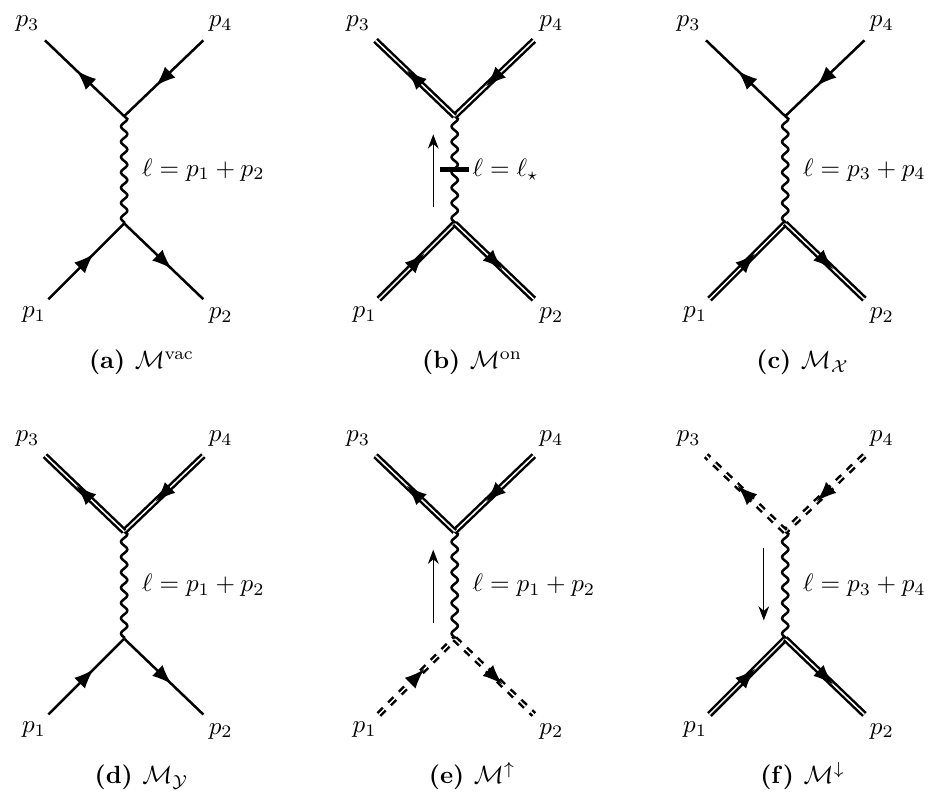
Figure 4. The decomposition (2.23) of the scattering amplitude M into gauge invariant pieces. Arrows denotes the momentum (cid:13)ow through the propagator. Dashed lines indicate the soft dressing. The cut in (cid:12)gure 4b indicates that the intermediate photon is on-shell, ‘ = ‘ ? with ‘ 2